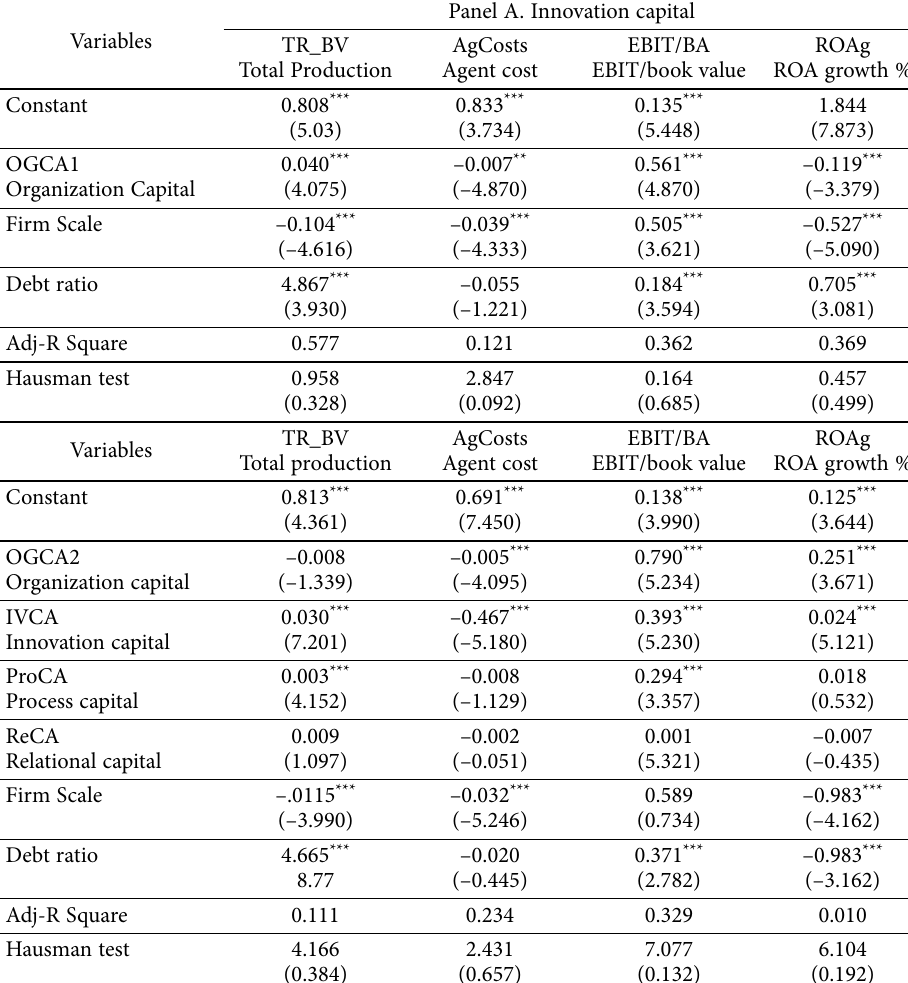
Table 5. Organization capital and corporate